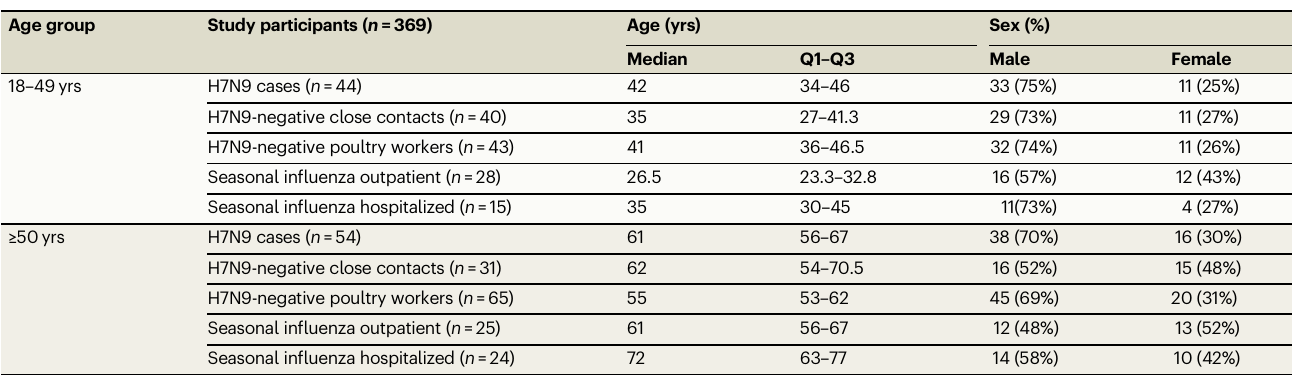
Table 1 | Characteristics of study participants Age